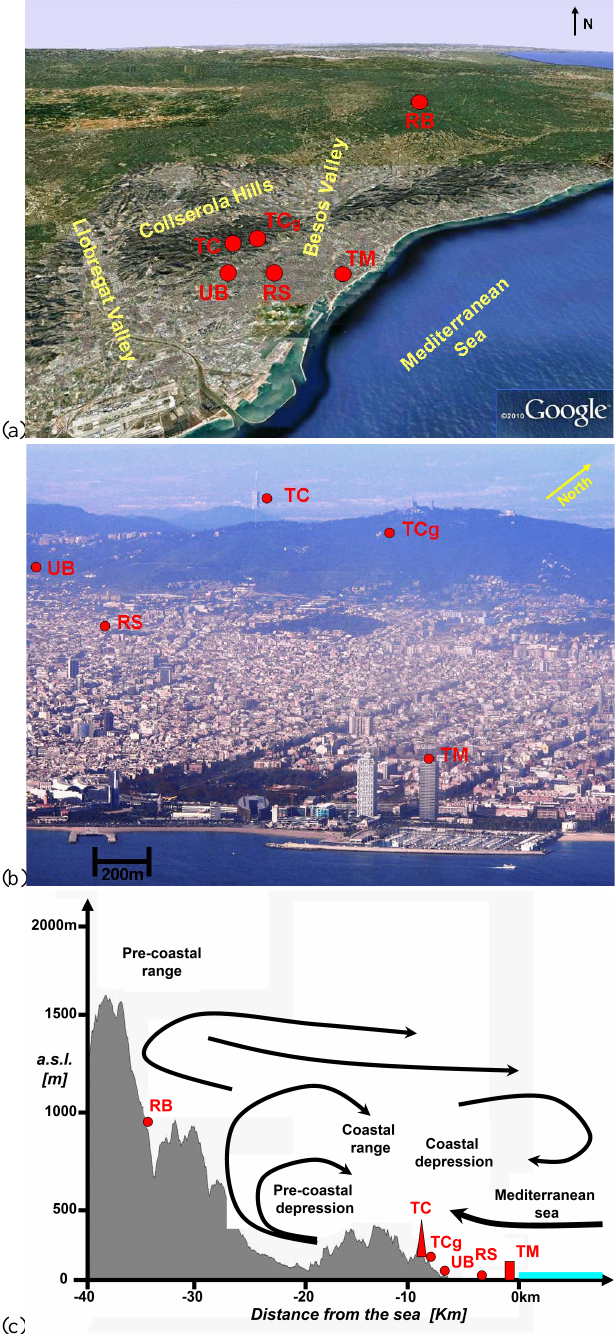
Fig. 1. (a–c) Maps of measurement sites used in SAPUSS: road site (RS), urban background (UB), Torre Mapfre (TM), Torre de Collserola (TC), Fabra observatory (TCg) and regional Montseny background site